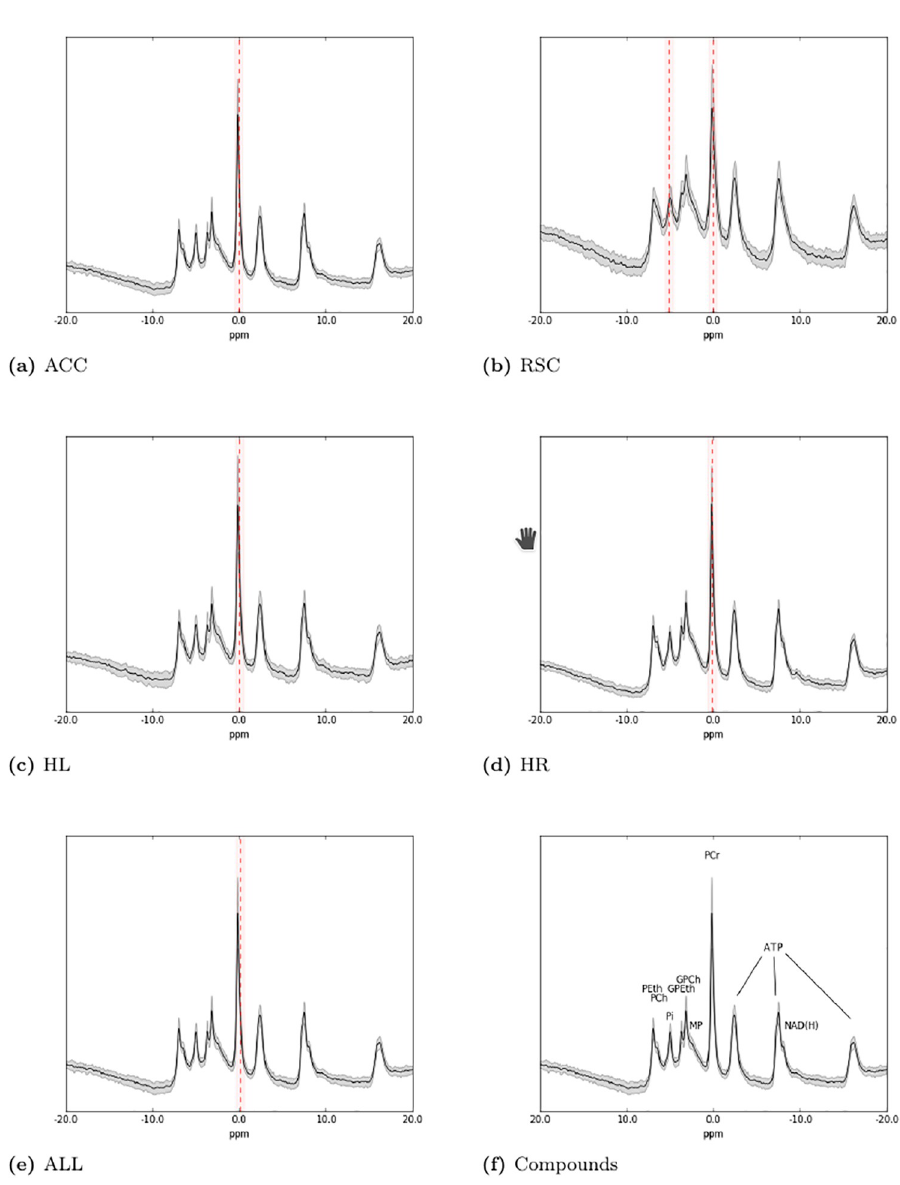
Fig 7. 31 P MR spectra of the brain of patients with Alzheimer’s disease. Important spectral regions identified for the Alzheimer’s disease dataset are shown for the ACC (a), the RSC (b), the HL (c), the HR (d) and their combination (e). A reference spectrum with annotated peaks is shown in (f). The average spectrum for each area is plotted as a reference in (solid) black and the gray zone around it shows the standard